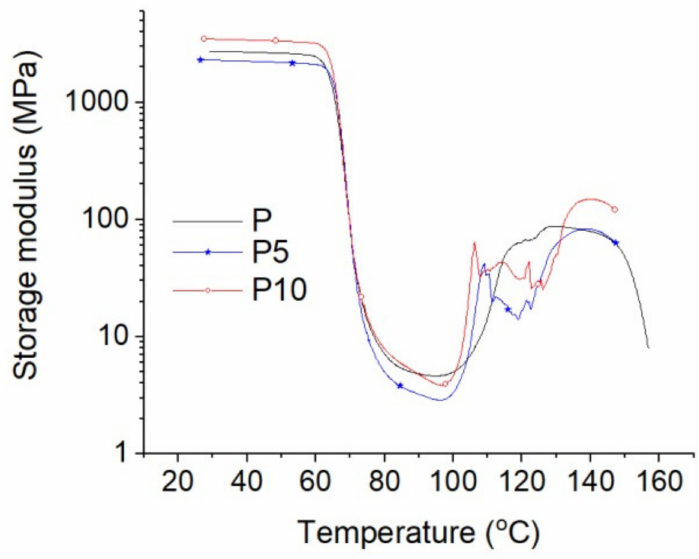
Figure 4. Storage moduli of samples P, P5, and